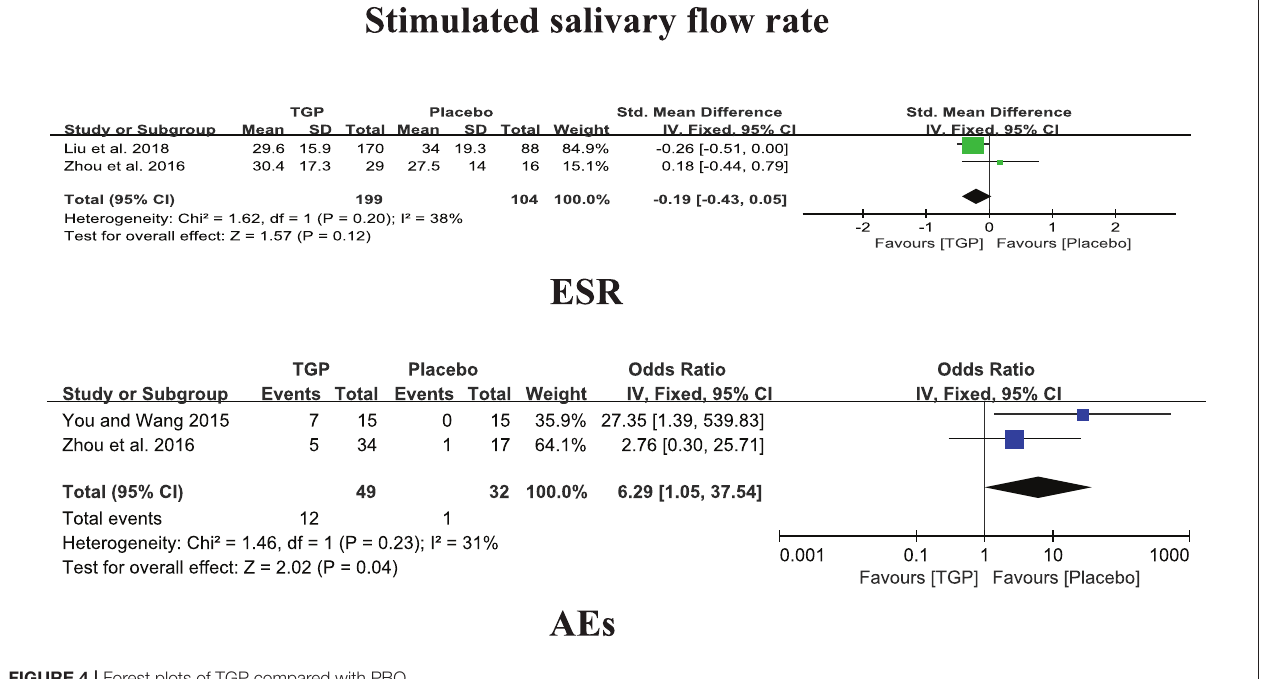
FIGURE 4 | Forest plots of TGP compared with